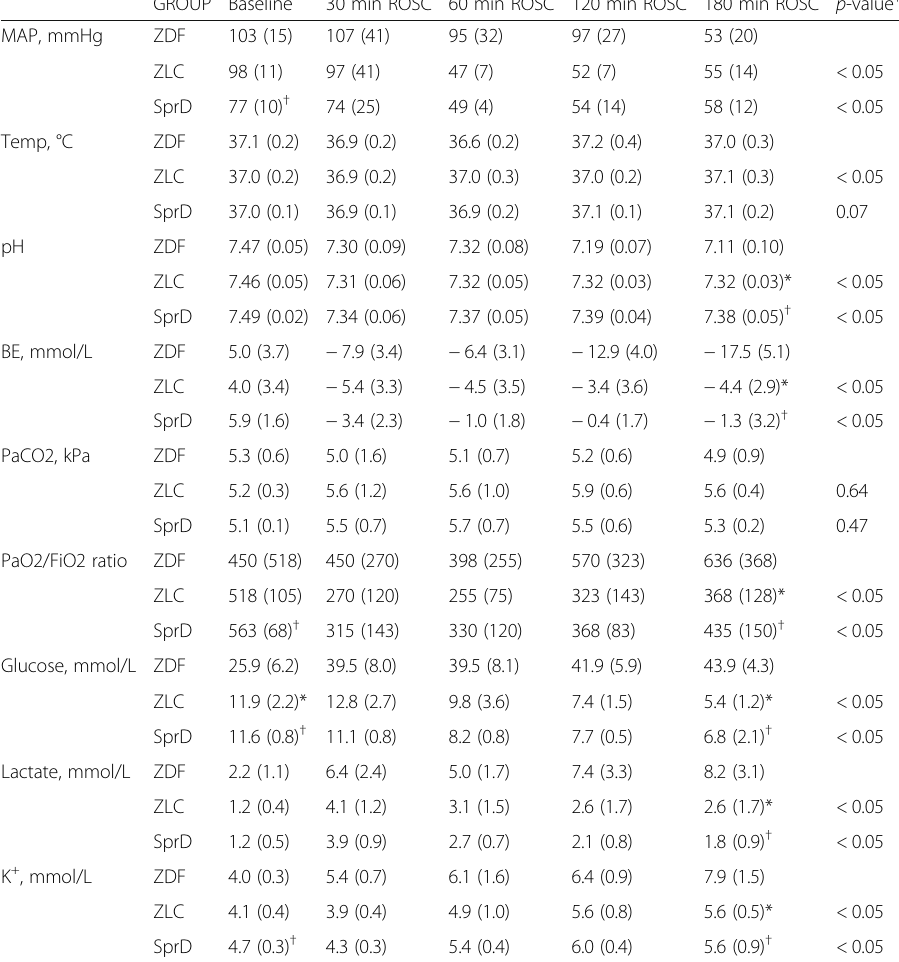
Table 2 Mean arterial pressure, heart rate, temperature, and blood gas analysis GROUP